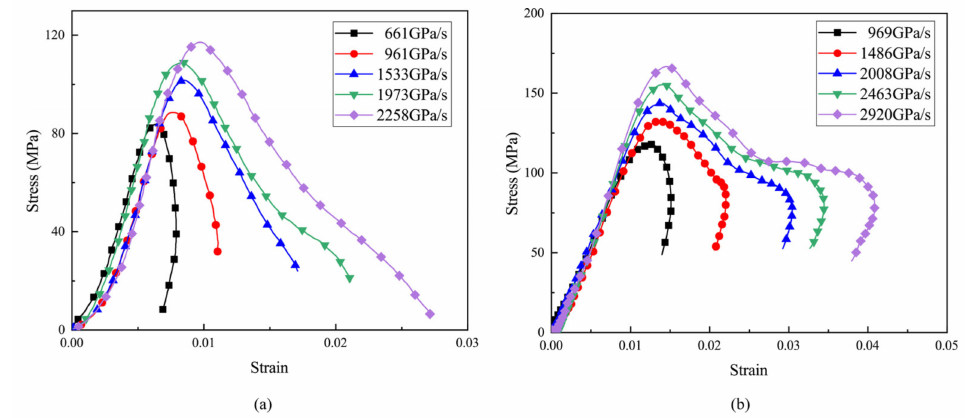
Figure 8. Dynamic compressive stress–strain curves of the specimen under different working condi- tions: ( a ) 0 FTC and 0 MPa; ( b ) 0 FTC and 2 MPa.